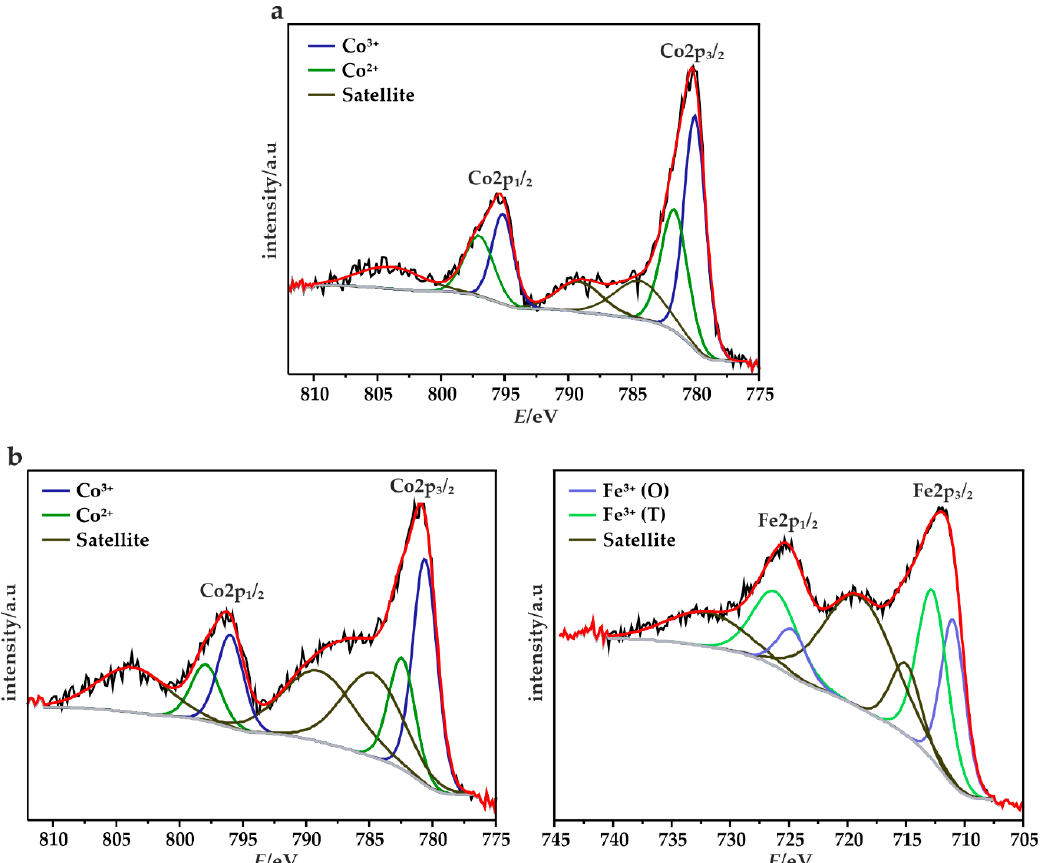
Figure 4. The XPS spectra of the Co 3 O 4 /MPC catalysts in core level spectrum of Co2p ( a ) and of Fe-Co_1.5/MPC catalysts core level spectrum of Co2p and Fe2p ( b ).